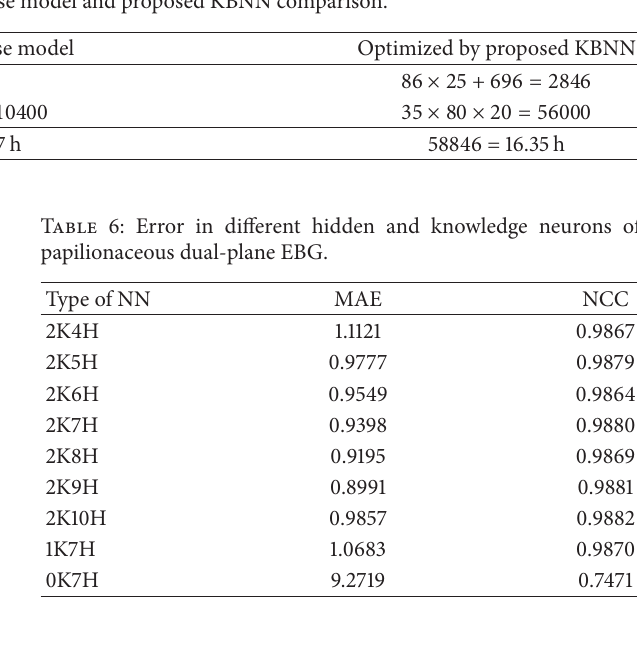
Table 5: Time of optimization by precise model and proposed KBNN comparison.